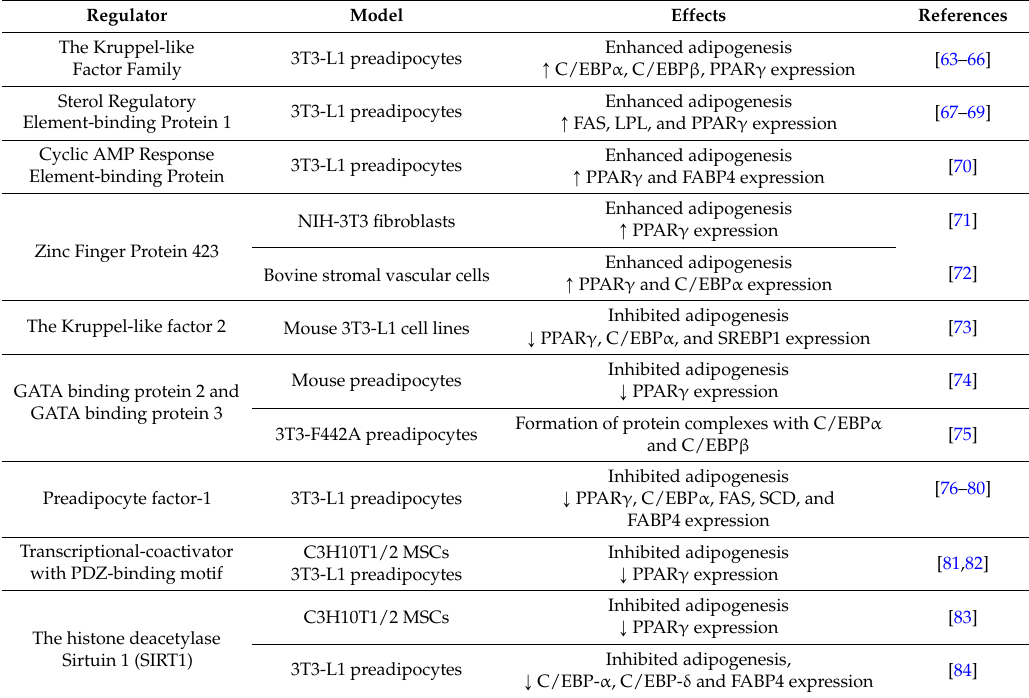
Table 1. Roles of different regulators on